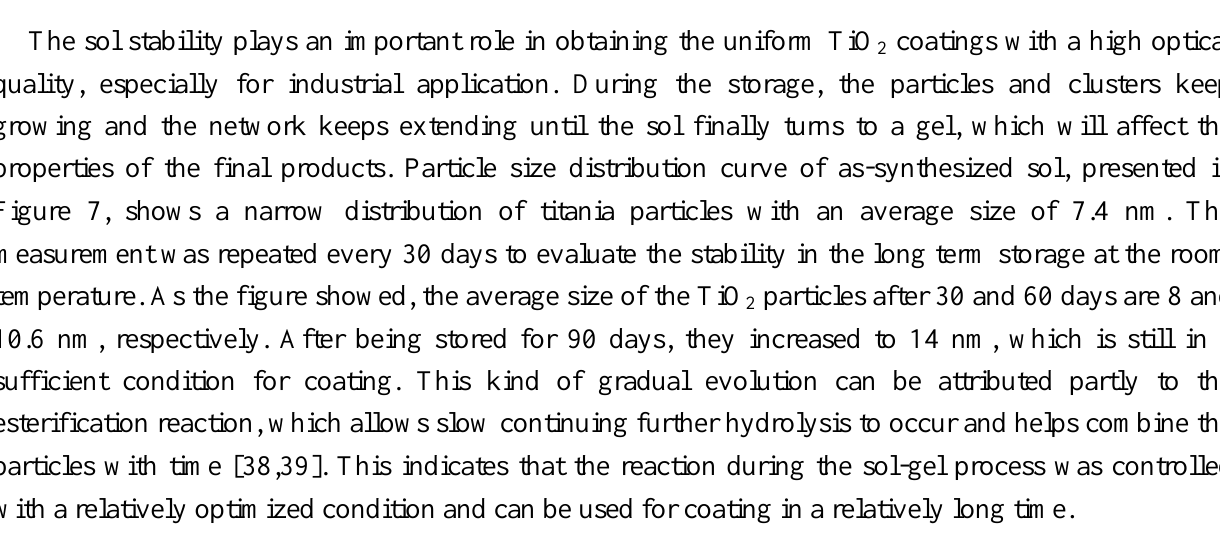
Figure 7. Particle size distribution of TiO